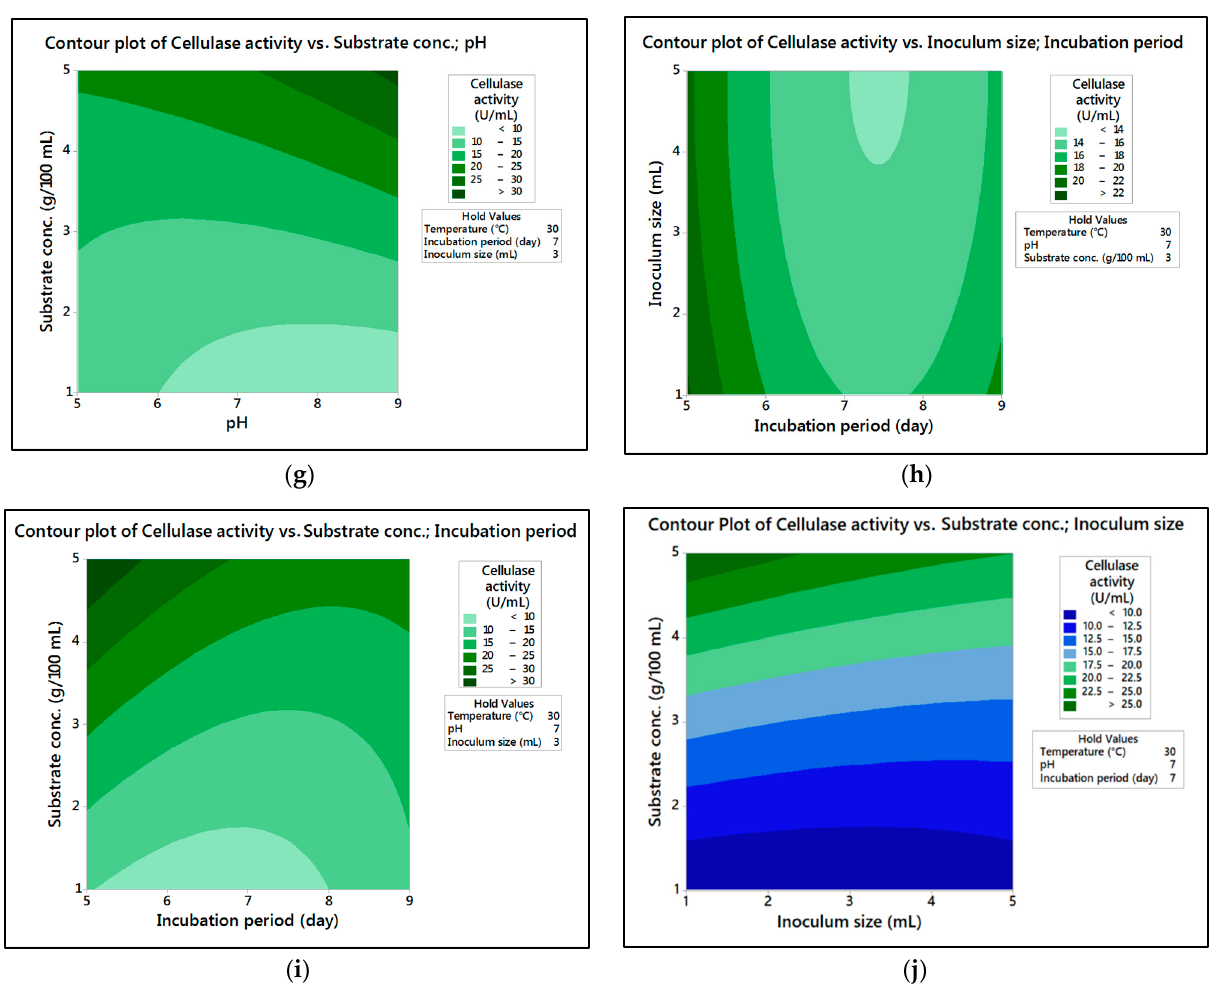
Figure 3. Contour plot showing interactions between independent variables: ( a ) incubation tem- perature with pH; ( b ) incubation temperature with incubation period; ( c ) incubation temperature with inoculum size; ( d ) incubation temperature with substrate concentration; ( e ) pH with incubation period; ( f ) pH with inoculum size; ( g ) pH with substrate concentration; ( h ) incubation period with inoculum size; ( i ) incubation period with substrate concentration; ( j ) inoculum size with substrate concentration for cellulase activity produced by M. circinelloides .